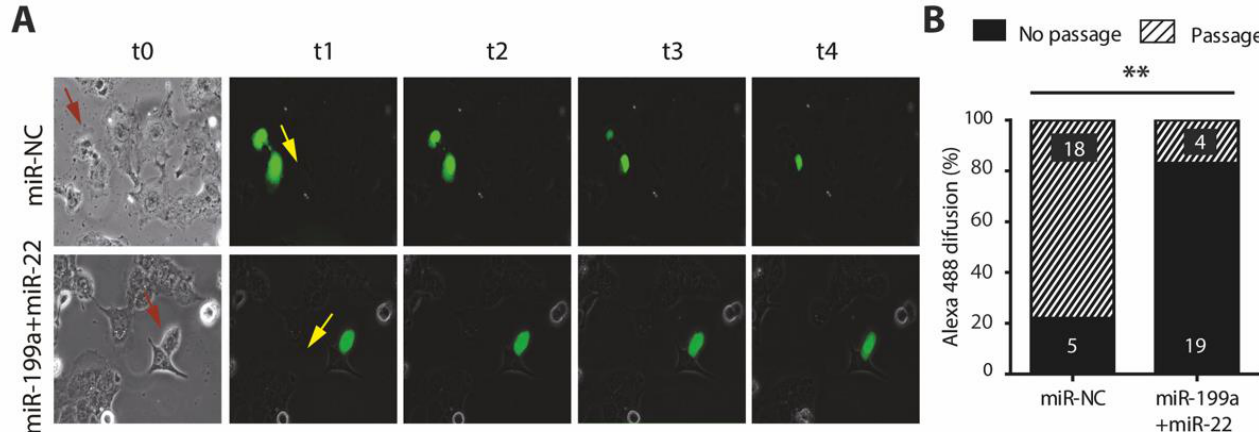
Figure 5. Cell-to-cell communication in HL-1 cells transfected with miR-199a+miR-22 (white) or miR-NC (black) ( A ). A representative experiment following the pass of Alexa 488 between two cells (pairs seen in the left bright field image with the injected cell marked with a red arrow, and the expected direction of Alexa flow is marked with a yellow arrow). Images were taken at four different time points over the course of 90 min (t1–t4). The passage through these cells was so fast that even at the beginning of the recording (t1) the fluorescent dye was already present in both cells ( B ). Percentage of cells that allowed (stripped) or did not allow (plain) passage of Alexa 488 to neighboring cell. Numbers within the columns represent the absolute value of cells, with a total of 23 in both cases. ** p < 0.005.